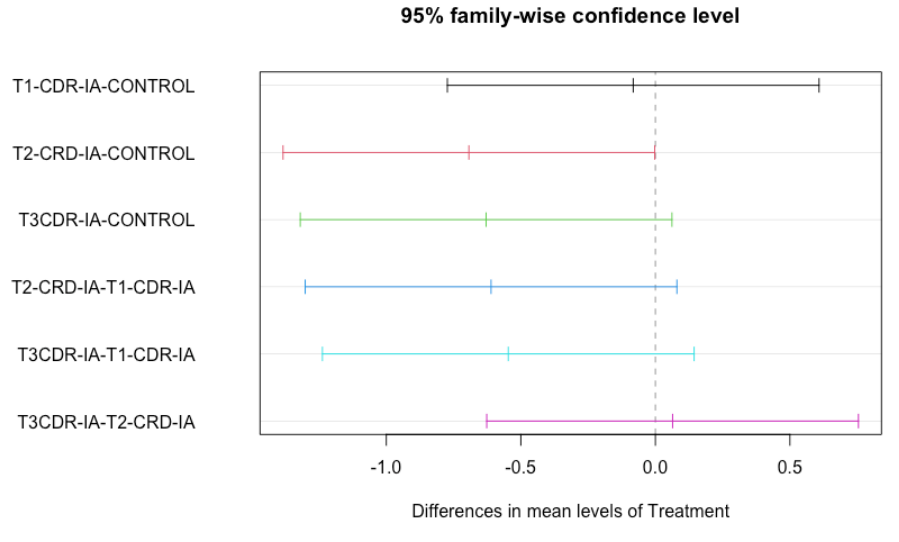
Figure A5. Confidence Intervals for Tukey Test for anophelines.